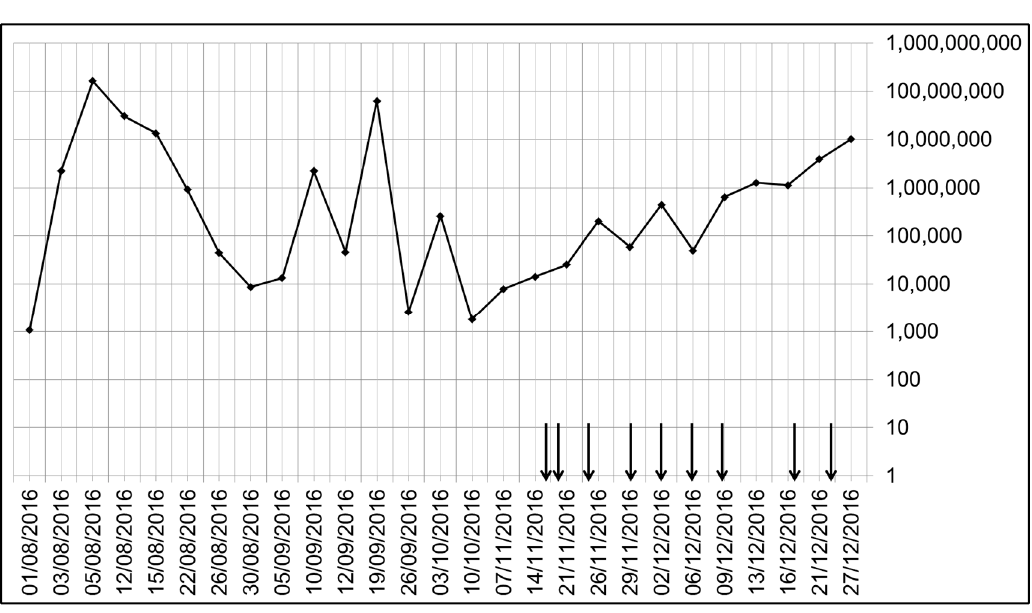
Figure 3. Variable AdV DNA levels in the routine patients nasopharyngeal aspirates (NPAs). Note that the date increases from left to right along the x -axis, and the y -axis (placed on the right-hand side to allow easier comparison with dates of sampling) shows the AdV DNA in copies/mL VTM. Air sampling was performed on the dates indicated by the vertical black arrows. Despite high NPA AdV DNA levels at times, no AdV DNA was detected in any of the air samples with the same routine commercial diagnostic respiratory PCR assay (spiked samples with positive AdV DNA extract showed no inhibition from the gel filter).